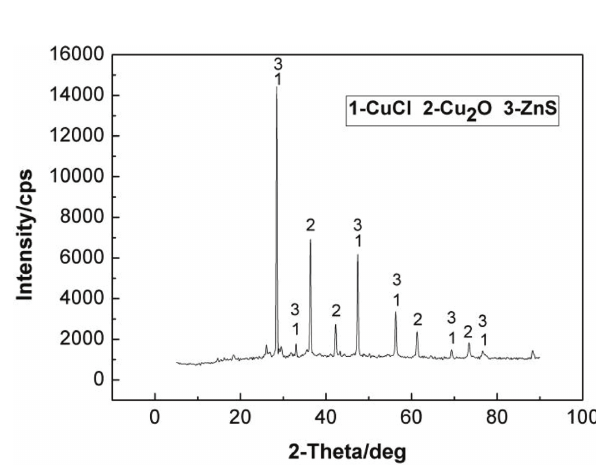
Figure 1: XRD pattern of the raw material.